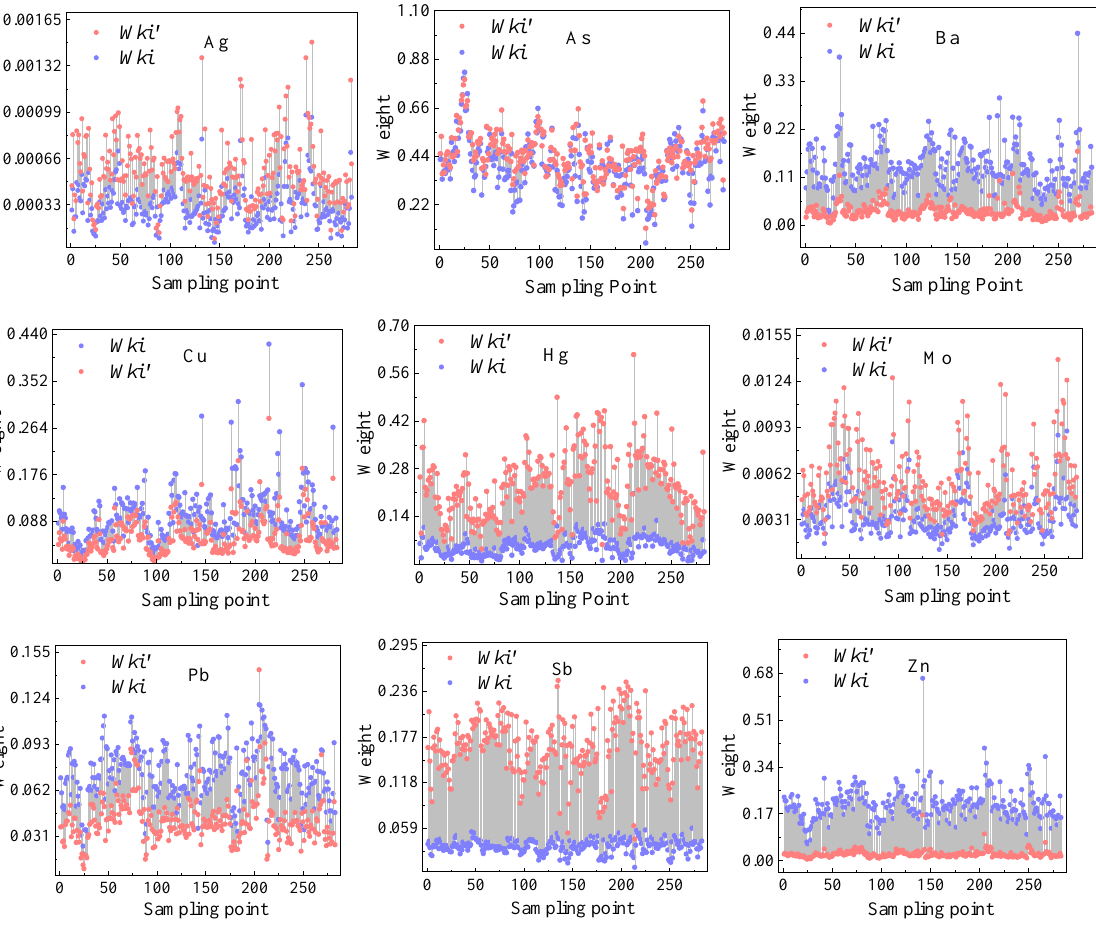
Figure 3. Comparative Analysis of weight values of potentially toxic elements in soil of the study area. (4) Evaluation